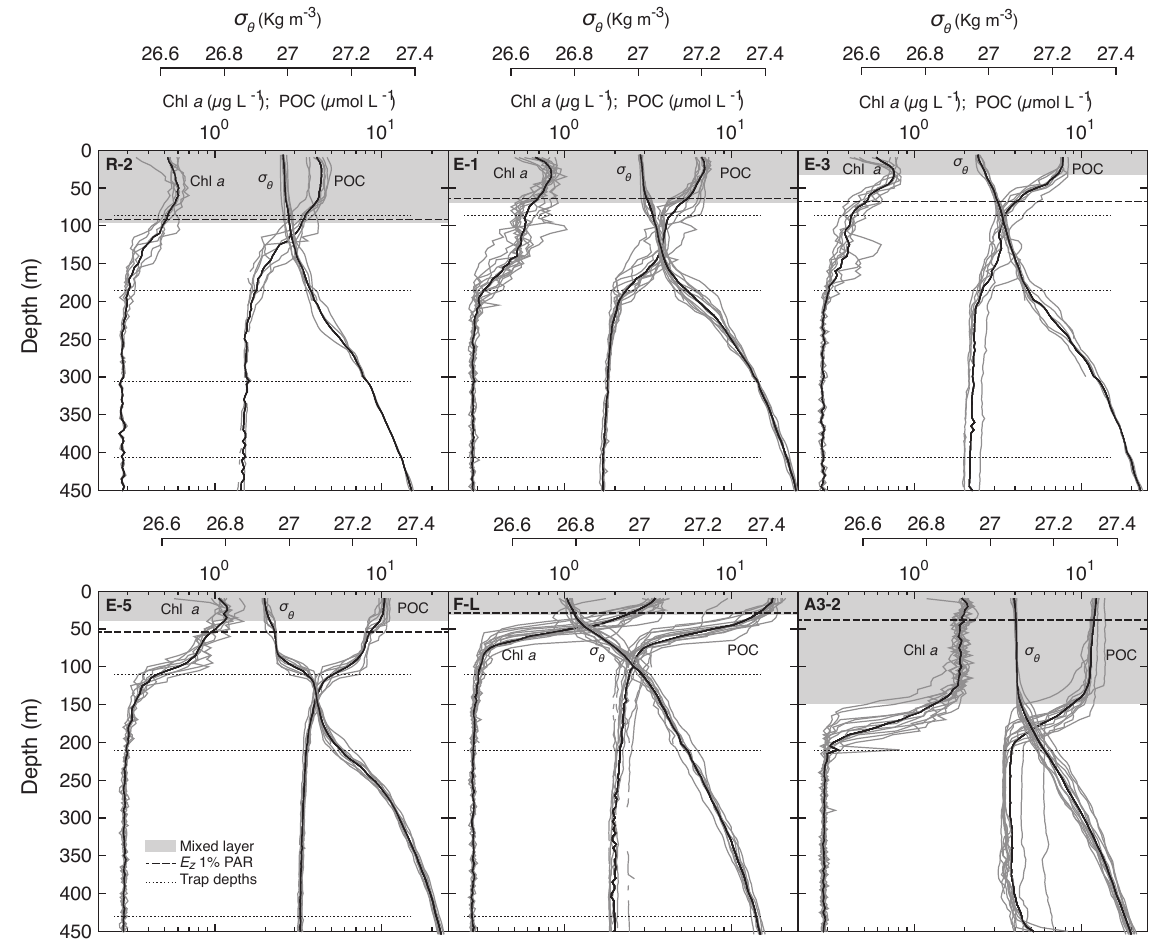
Figure 2. Water column properties and biomass at each site. Chl a : chlorophyll a (µgL − 1 ); σ θ : potential density anomaly (kgm − 3 ); POC: particulate organic carbon (µmolL − 1 ). Grey lines indicate CTD profiles and black lines represent their average values. E Z 1% PAR: base of the euphotic zone assumed at 1% of the photosynthetic available radiation